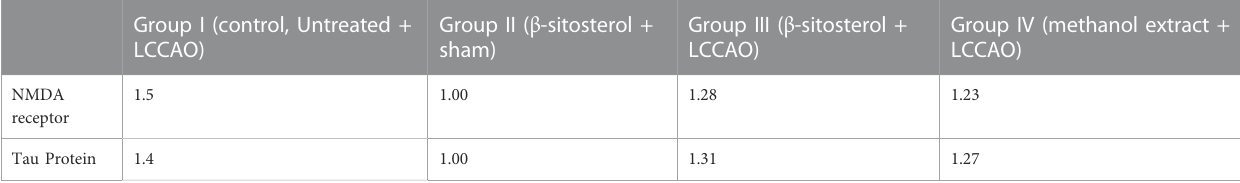
TABLE 3 Gene expression of NMDAR and Tau protein in left cerebral hemisphere homogenate. Group I (control, Untreated +